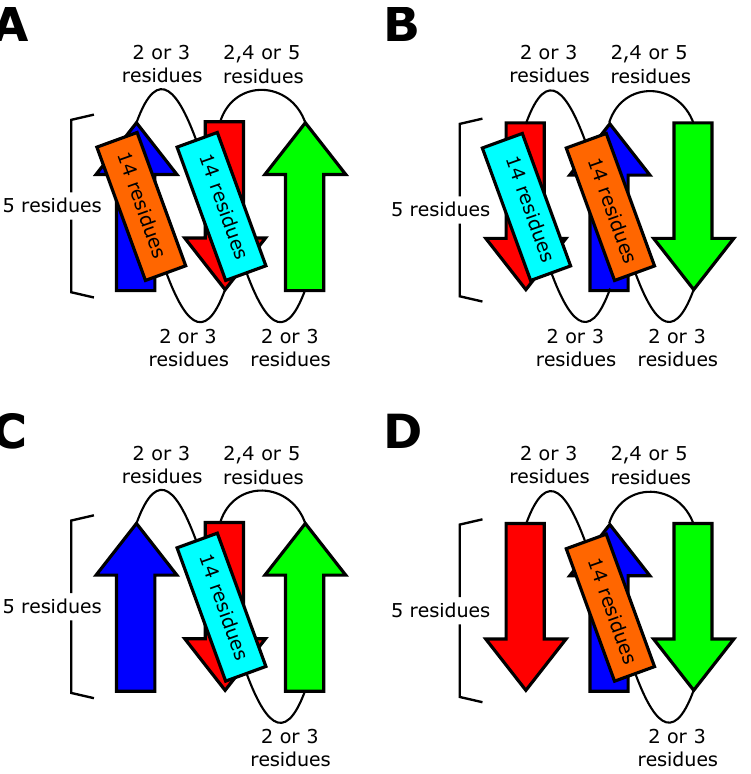
Figure 8. Blueprints used in the Rosetta folding simulations. The blueprints are represented by β - strands (arrows), α -helices (rectangles), and loops (curved lines). Blueprints of ( A ) the 1 ↑ 3 ↓ 2 ↑ + C-term α topology, ( B ) the 3 ↓ 1 ↑ 2 ↓ + N-term α topology, ( C ) the 1 ↑ 3 ↓ 2 ↑ topology, and ( D ) the 3 ↓ 1 ↑ 2 ↓